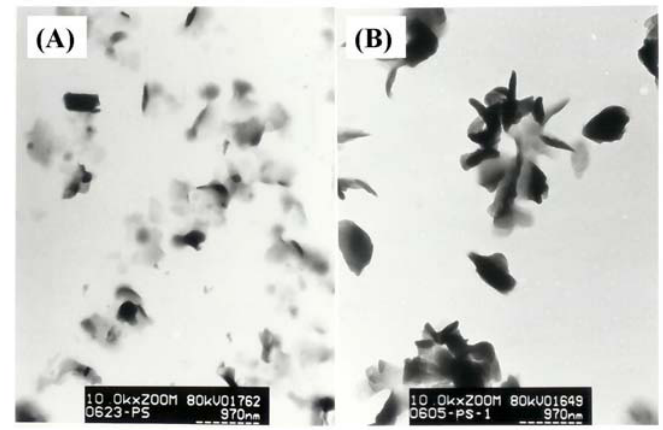
Figure 2. TEM images of 3a (A) and 3b